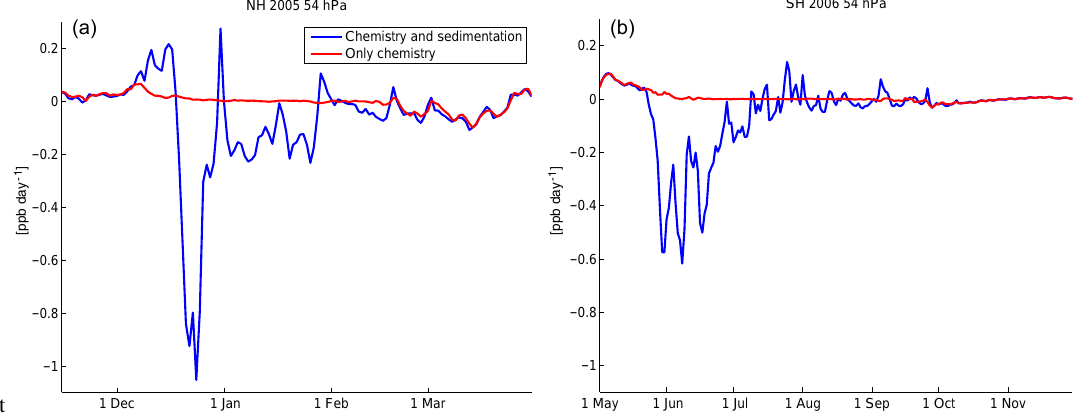
Figure 3. Vortex-averaged net chemical reaction rate of HNO 3 (red) for the Arctic winter 2004–2005 (a) and the Antarctic winter 2006 (b) at 54hPa and sum of the vortex-averaged change by sedimentation and the net chemical reaction rate (blue).